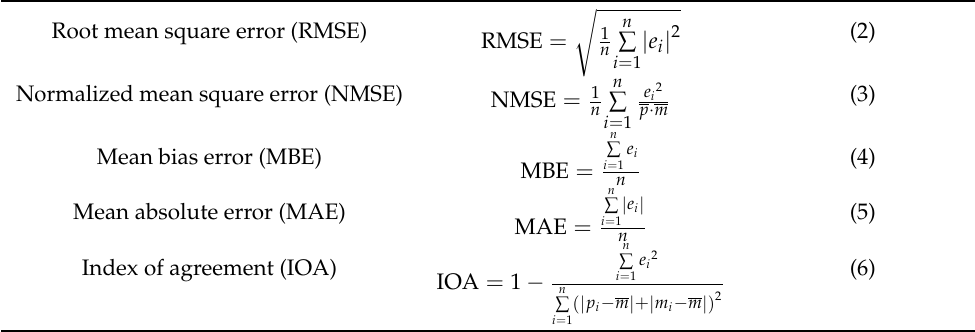
Table 1. Metrics to assess the performance of IDW interpolators. Root mean square error